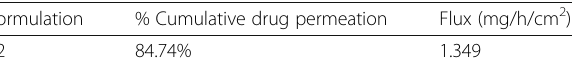
Table 5 Result of ex vivo % cumulative drug permeation and flux